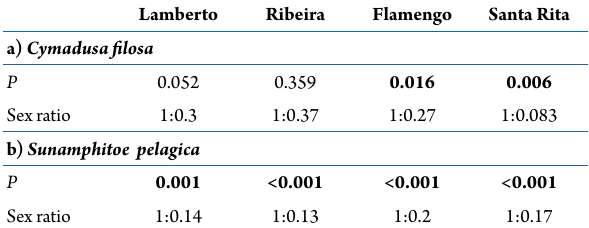
Table 3. Sex ratio and Binomial Test results (p-values) for deviations from a 1:1 ratio between sex categories (male:female) of amphipod populations at each site. ( a ) Cymadusa filosa ; ( b ) Sunamphitoe pelagica. Bold font indicates significant P